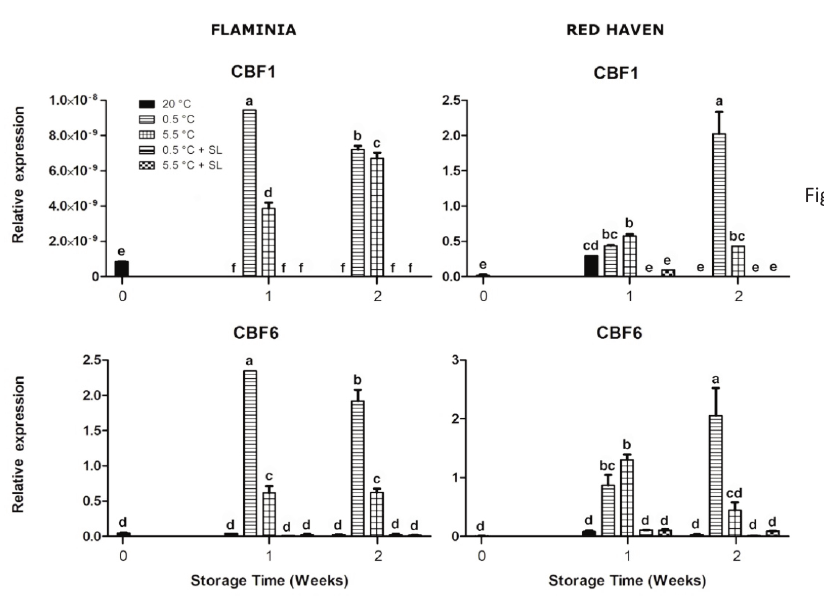
Fig. 5 ­ RT­qPCR analysis of two C­repeat­bin­ ding factors (CBF) genes. Mesocarp sam­ ples (cv. Flaminia, left panel; cv. Red Haven, right panel) were analysed at harvest (0), at the end of 1 and 2 weeks of cold storage at 0.5 and 5.5°C, and after three additional days of shelf life (0.5 and 5.5°C + SL). Samples kept at 20°C represent the room temperature control. The average value of three bio­ logical replicates is reported with bars representing SD. Letters indicate the results of Tukey's Honest Significant Difference (HSD) post hoc test, perfor­ med independently for each